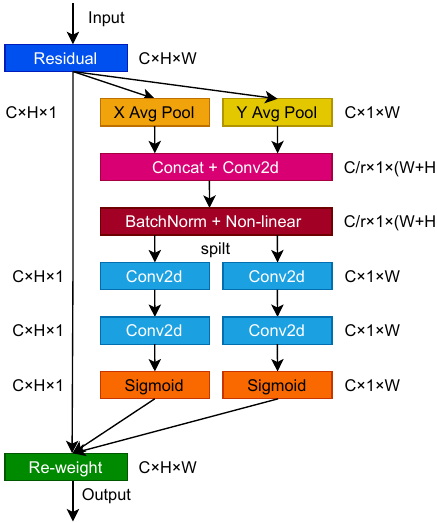
Figure 6. Convolutional coordinate